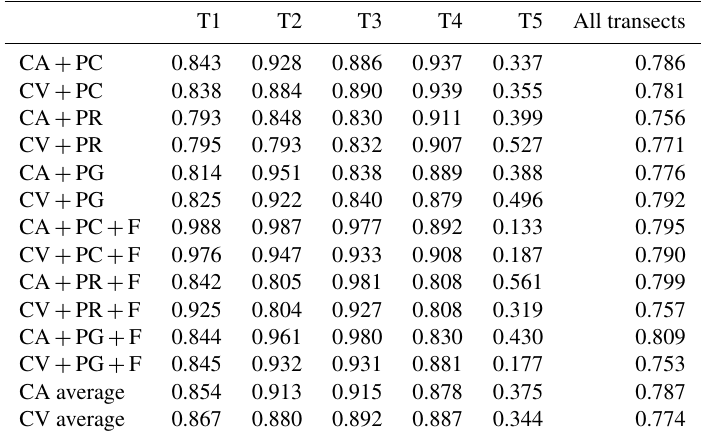
Table 7. Correlation coefficients between AGB simulated by INLAND and field estimates ( n = 310: 31 pixels × 10 years). T1